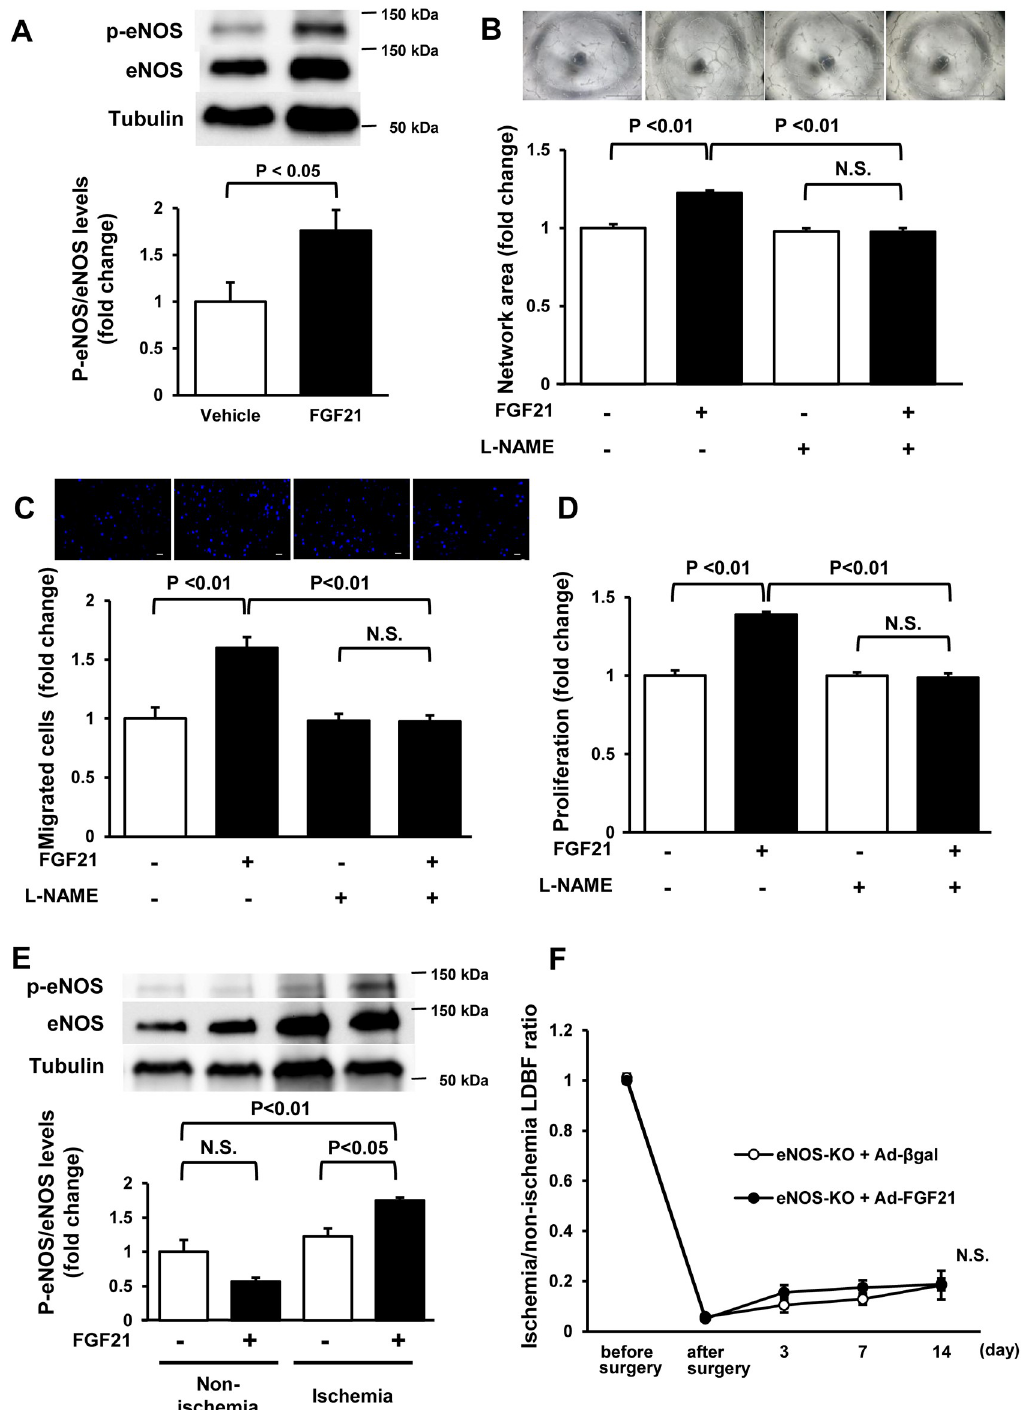
Fig 6. FGF21 promotes angiogenic response through the eNOS-dependent pathway. A . Phosphorylation of eNOS in HUVECs after treatment with FGF21. Upper panels show the representative blots of phosphorylated eNOS (P-eNOS), eNOS and α -tubulin (Tubulin) at 1 h after treatment with FGF21 (10 nM) or vehicle. Lower figure shows the quantitative analysis of phosphorylation levels of eNOS relative to Tubulin. N = 5 in each group. B-D . Involvement of eNOS in FGF21-induced enhancement of network structure (B), migration (C) and proliferation (D) of HUVECs. HUVECs were pretreated with the NOS inhibitor, L-NAME (500 μ M) followed by stimulation with FGF21 (10 nM) or vehicle. N = 8 in each group (B and C), N = 10 in each group (D). Scale bars show 1 mm (B) and 200 μ m (C). E . Phosphorylation of eNOS in non-ischemic